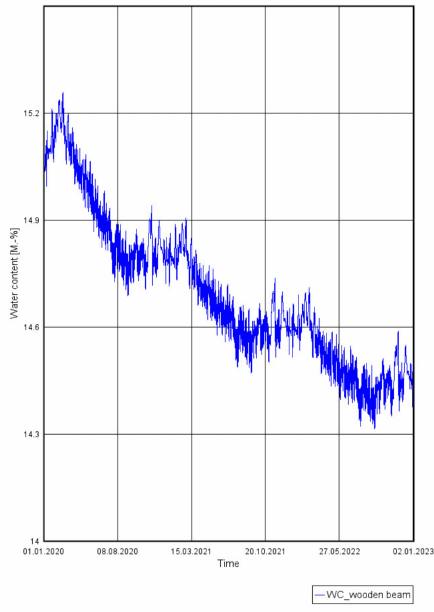
Figure 23. Changes in water content in a wooden beam—partition insulated using light aerated